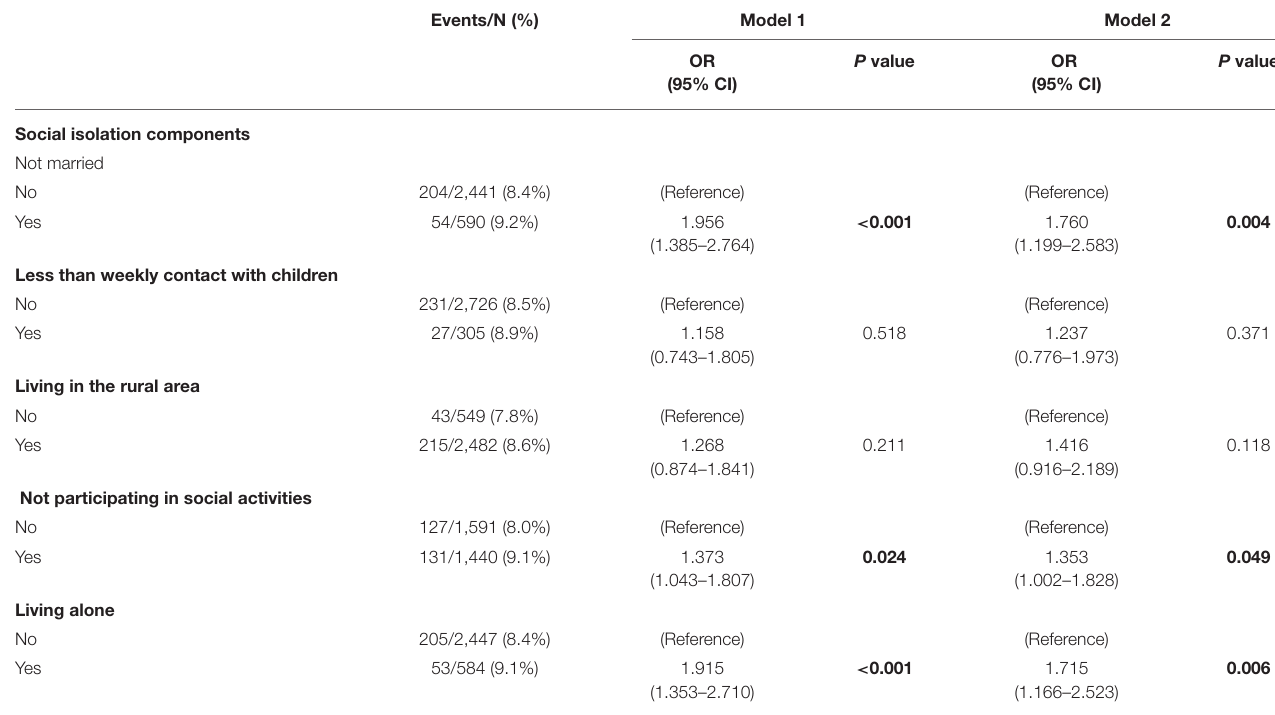
TABLE 3 | The relationships of social isolation and its components with rapid eGFR